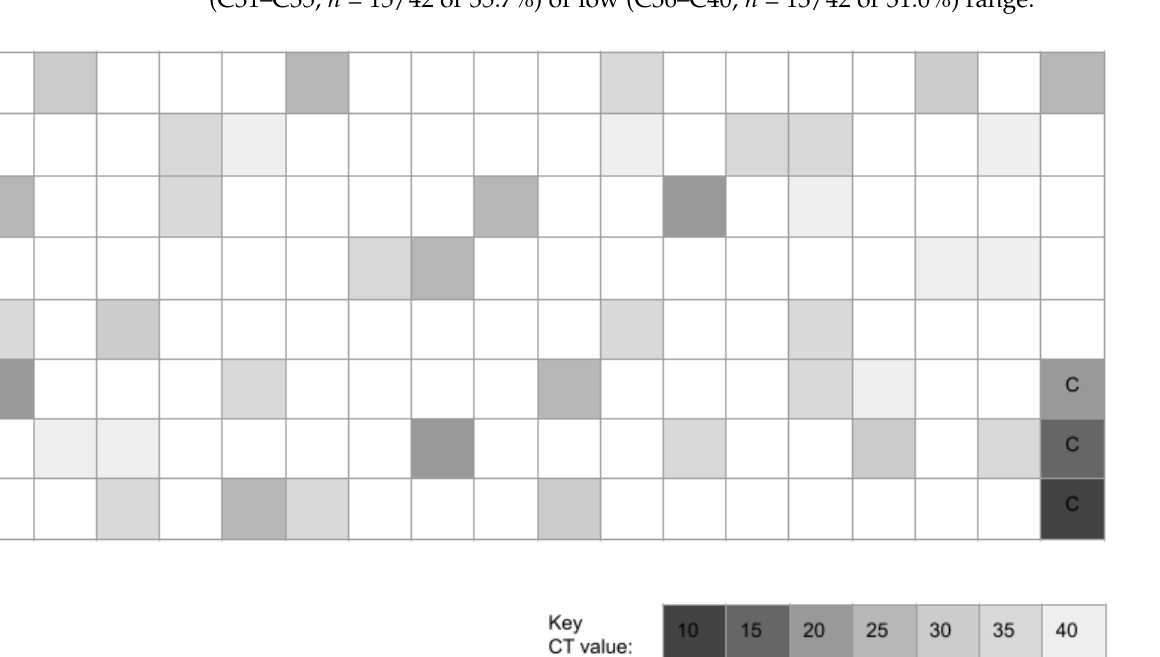
Table 4. Analysis of AM-positive and AM-negative pediatric samples.